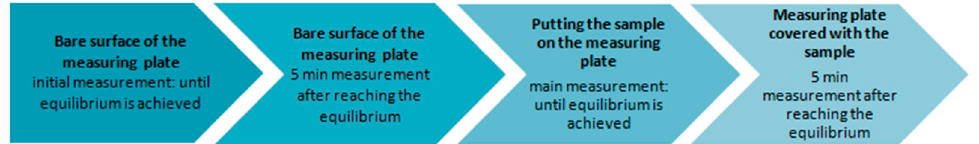
Figure 2. Scheme of testing the nonwoven inserts with PCMs on a “skin model” device. The samples were acclimatized for 24 h in a cooling chamber at 0 °C (i.e., at